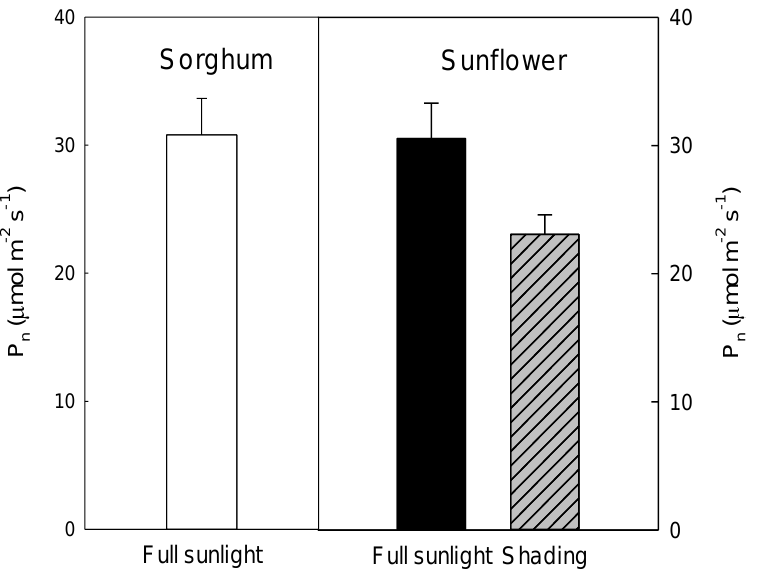
Figure 7. Light-saturated photosynthetic rates (P n ) of sorghum and sunflower leaves. Plants grown under full sunlight or weak light (10% full sunlight).